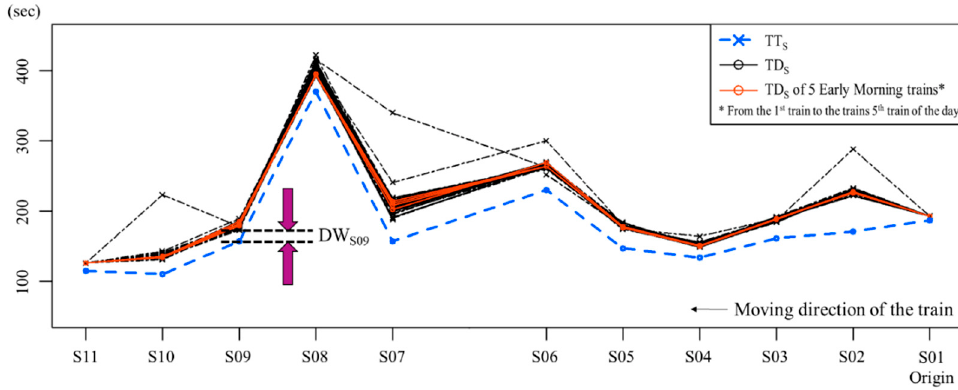
Figure 6. TT S and TD S at each station and the concept of estimating the DW S at each station.